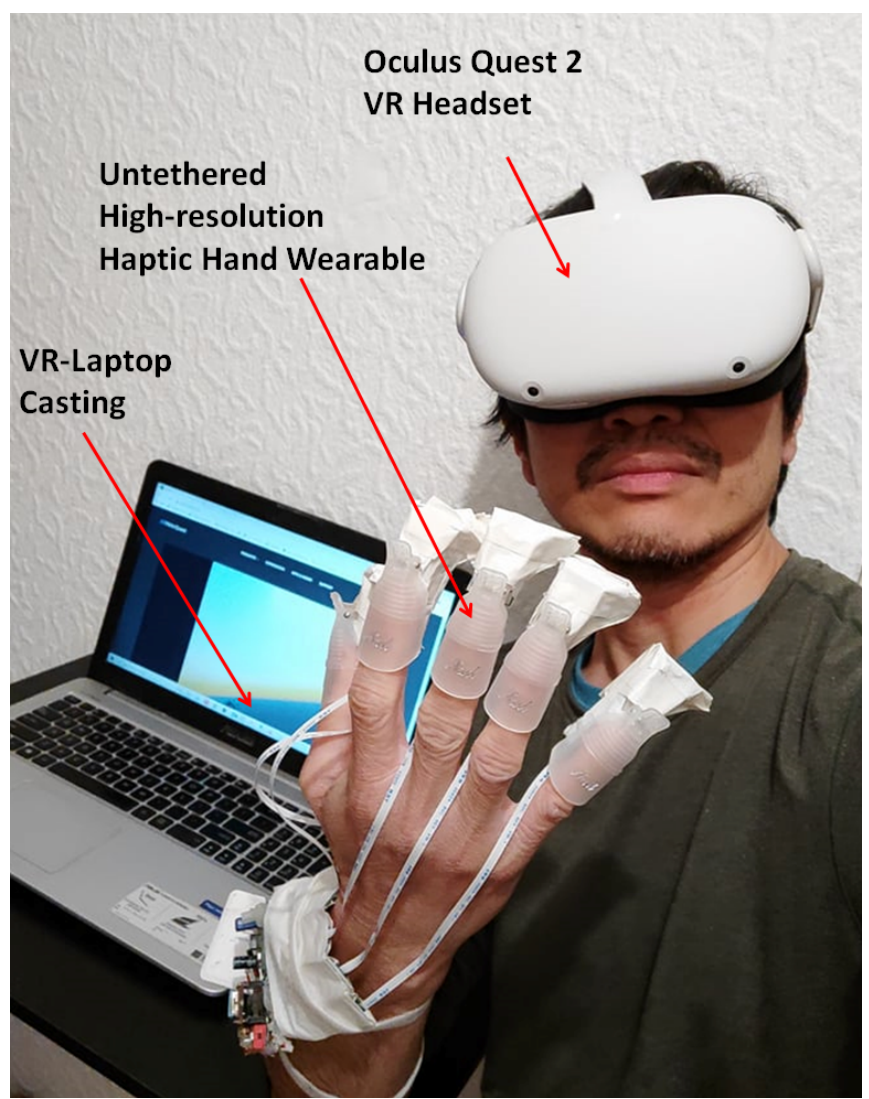
Figure 14. Setup for 3D surface scanning of VR objects using Oculus Quest 2 VR